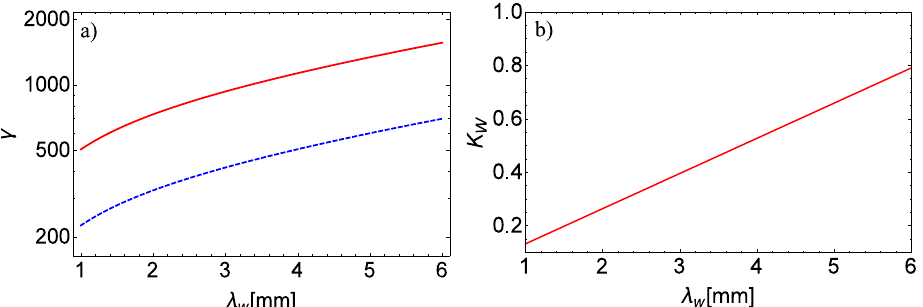
Figure 2. ( a ) Electron relativistic factor vs. the undulator wavelengths for λ r ≡ 1 nm (continuous line) and λ r ≡ 5 nm (dashed line). ( b ) K w values vs. λ w used to plot the graphs in (a) assuming I w = 2.4 × 10 14 W / m 2 .